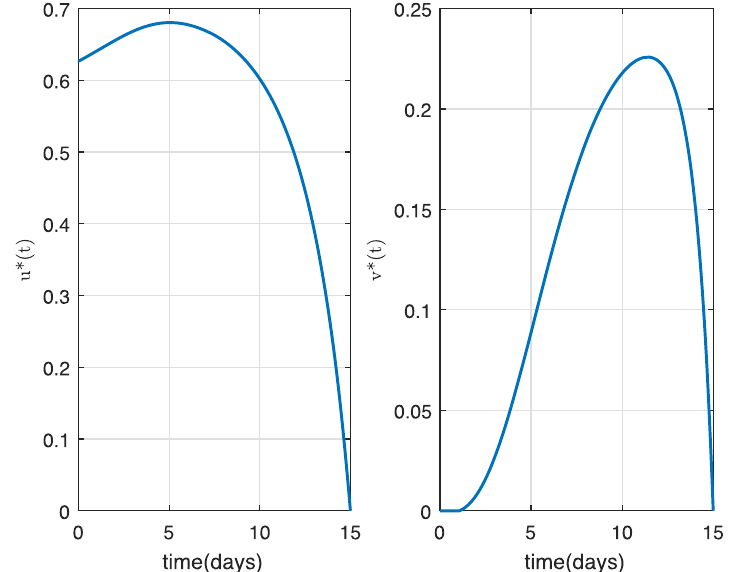
Figure 6: Optimal controls paths